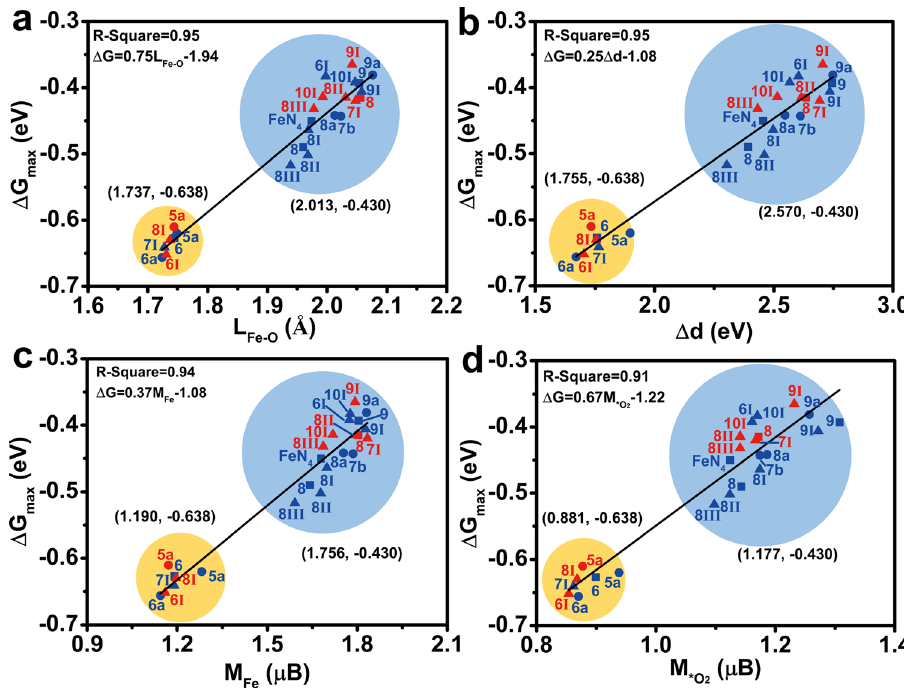
Fig. 3 Exploring the descriptors of Fe-N 4 ORR activity. Correlation between the a L Fe – O (Fe – O bond length), b Δ d (the d-band center gap of Fe spin state), c M Fe (the spin magnetic moment of Fe), d M *O2 (the spin magnetic moment of *O 2 ) and the ORR activity of Fe-N 4 site. Blue and red represent upper and lower surface activity, respectively. Golden and blue circles represent the active and inactive Fe-N 4 site,